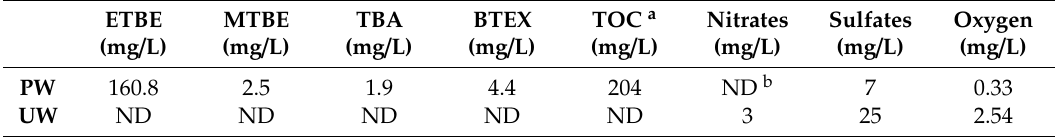
Table 1. Chemical analysis of water from the upstream (UW) and the polluted (PW) well.